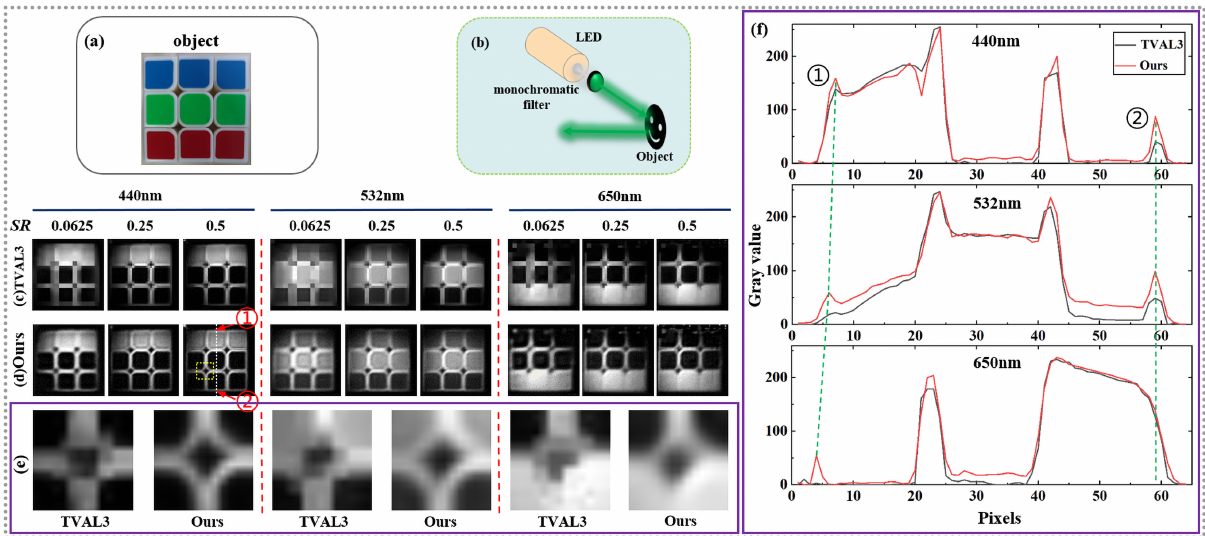
Figure 4. Multispectral imaging of a third-order Rubik’s cube with RGB color distribution. The size of the reconstruction images is 64 × 64 pixels. ( a ) The object. ( b ) A setting suitable for the reflecting object. ( c , d ) Reconstruction spectral images with central wavelengths of 440 nm, 532 nm, and 650 nm at the SR of 6.25%, 25%, and 50% by TVAL3 and the proposed method, respectively. ( e ) Enlargements of the images in the yellow dotted box of ( c , d ) at the SR of 50%. ( f ) The intensity profiles across the white dotted line in the reconstruction images at the SR of 50% in ( c , d ) vs. pixel number for different spectra bands. We select two groups of particular pixels (cid:172) and (cid:173) , which are connected across the spectral bands with the green dotted